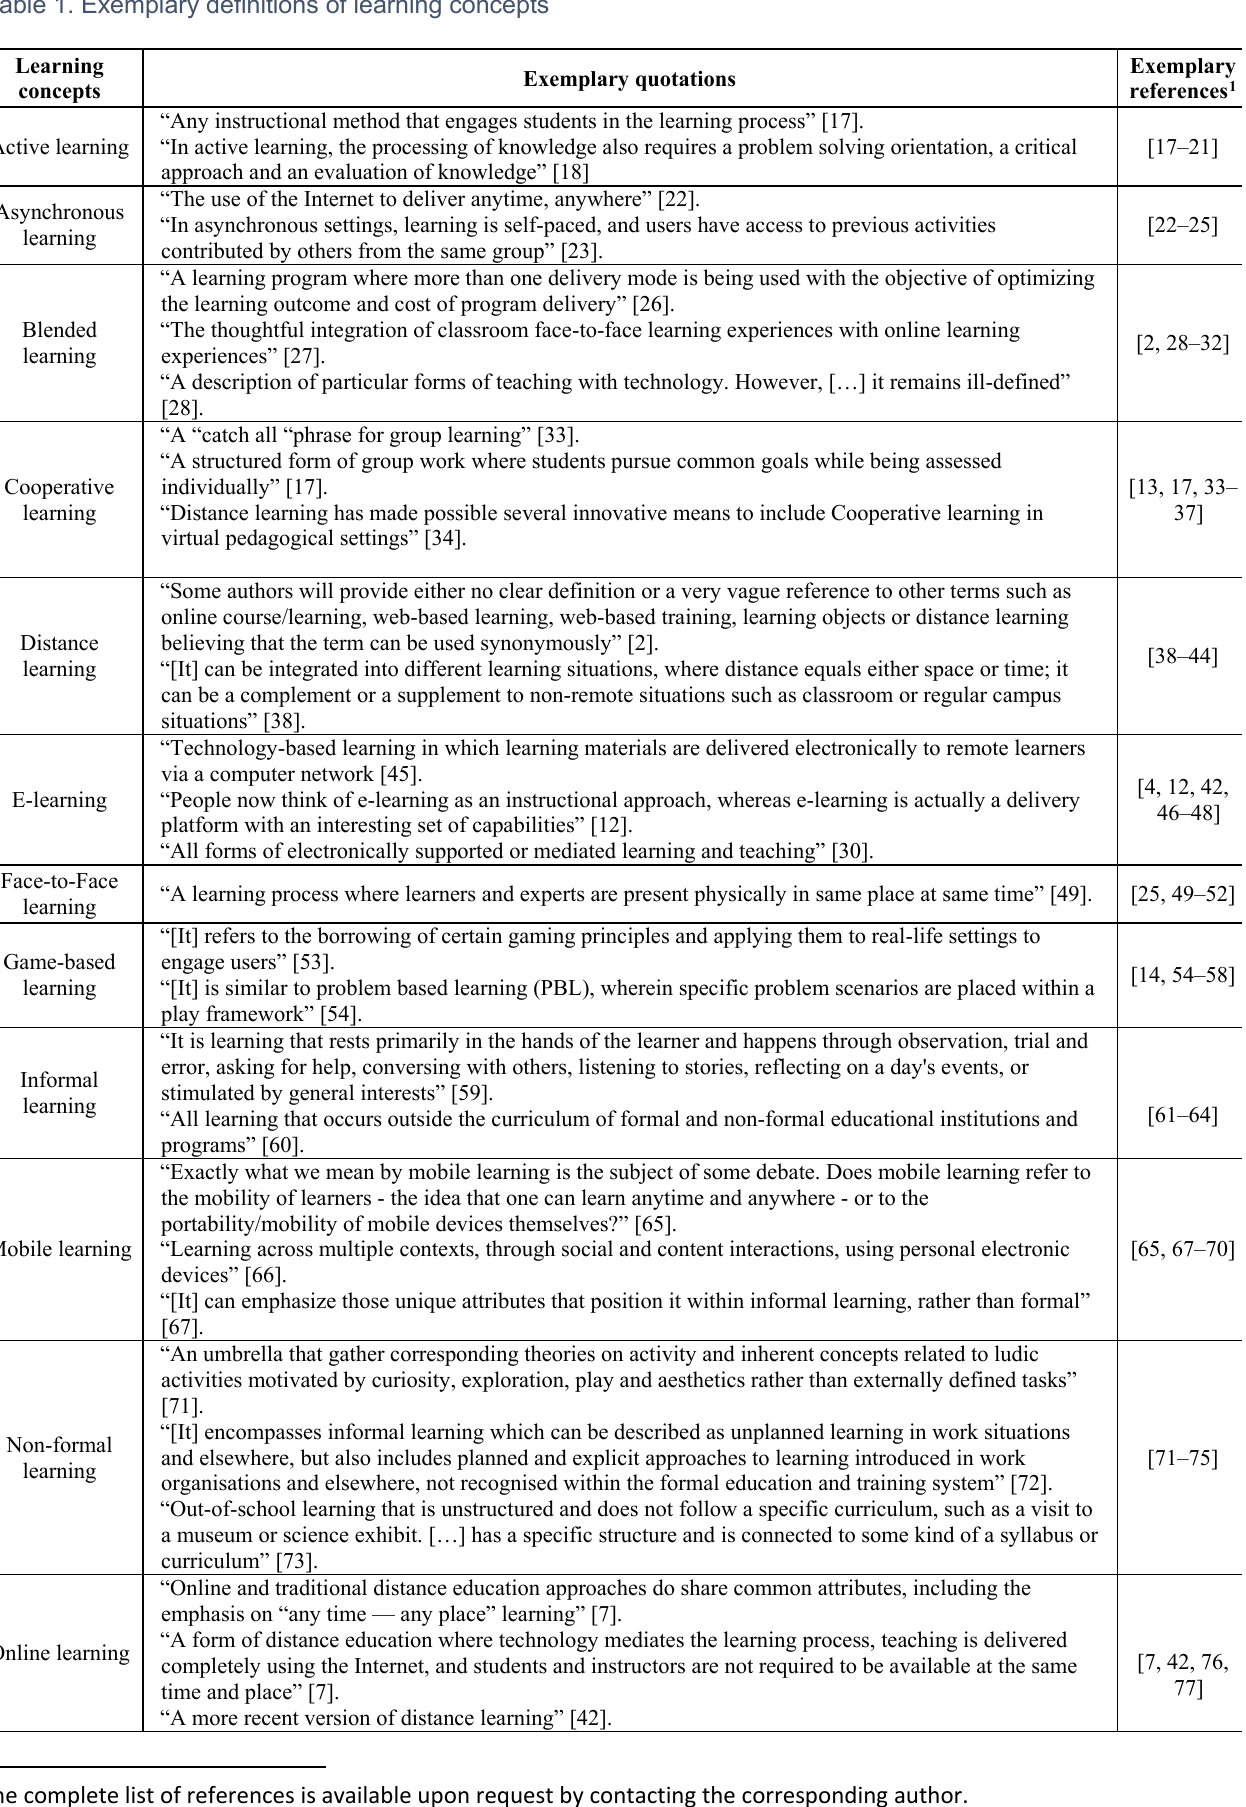
Table 1. Exemplary definitions of learning concepts Learning